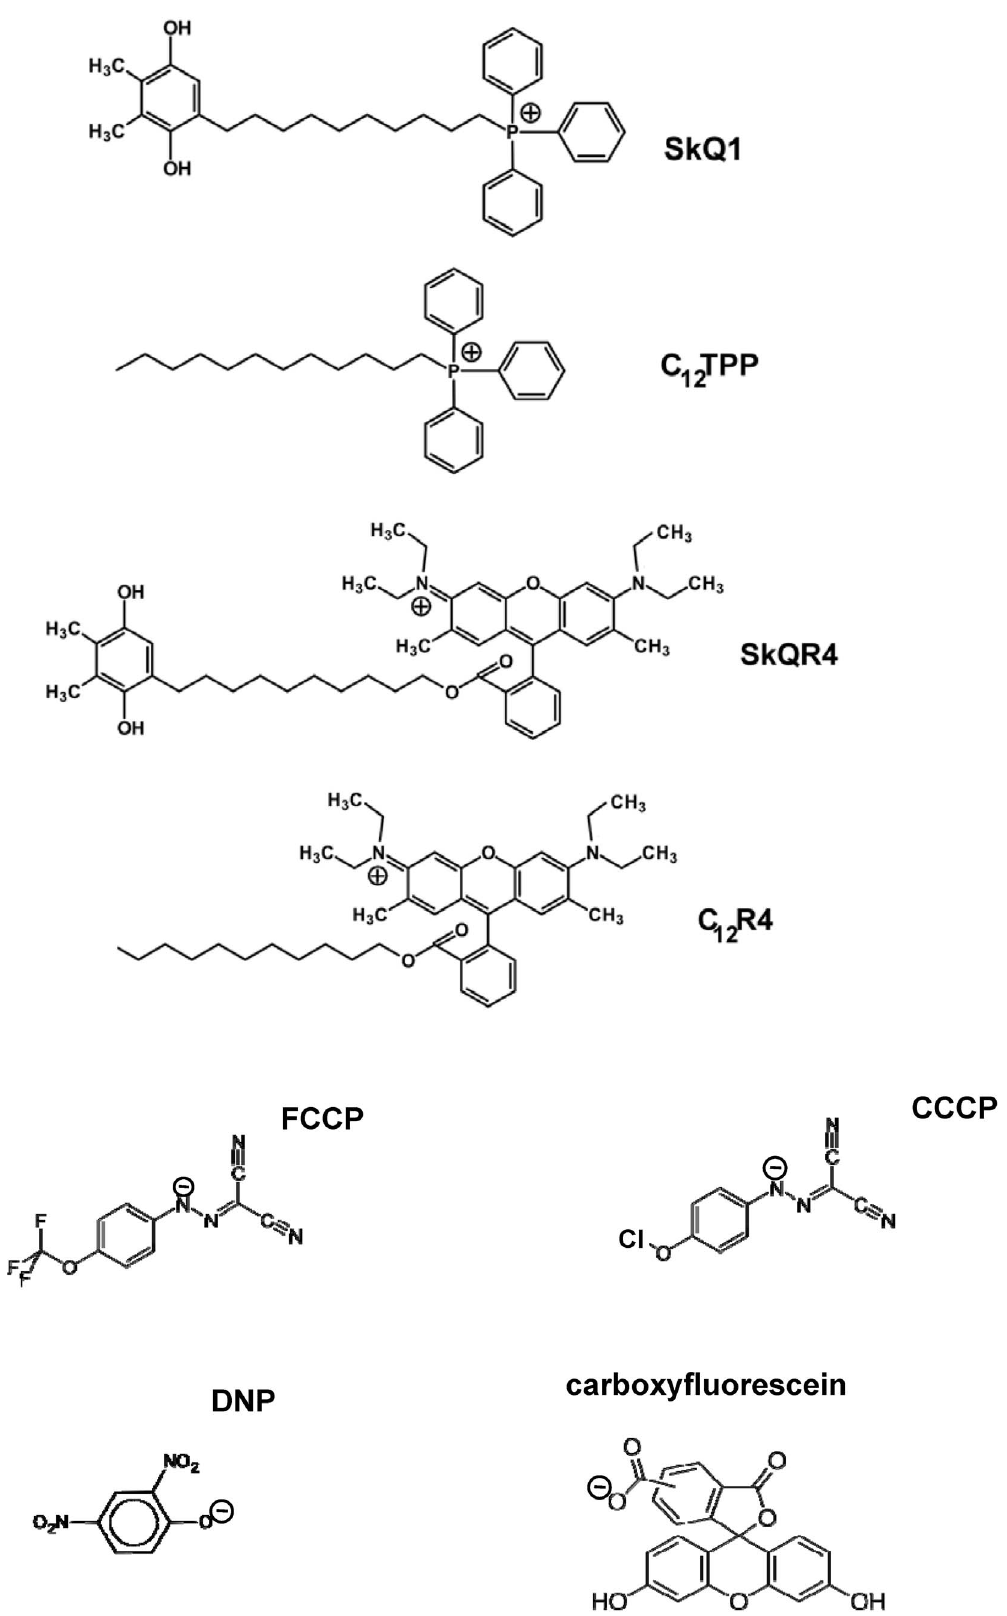
Figure 1. Chemical structures of C 12 TPP, SkQ1, SkQR4, C 12 R4, FCCP, CCCP, DNP, and carboxyfluorescein.